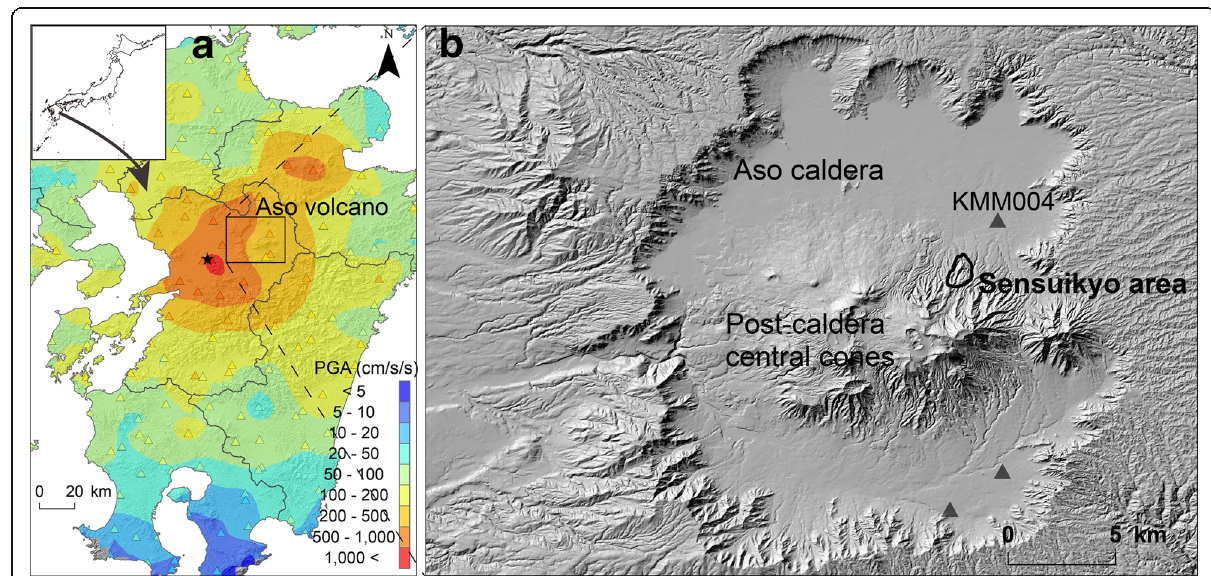
Fig. 1 Study area. a Distribution of the peak ground acceleration (PGA; cm/s/s) of the Mw 7.1 main shock of the 2016 Kumamoto earthquake on April 16, derived from records from the K-NET and KiK-net strong motion network (triangles) of the National Research Institute for Earth Science and Disaster Resilience (NIED). The star shows the hypocenter. b Aso caldera and location of the Sensuikyo area (black polygon). KMM004 represents the Ichinomiya station of K-NET and KiK-net of